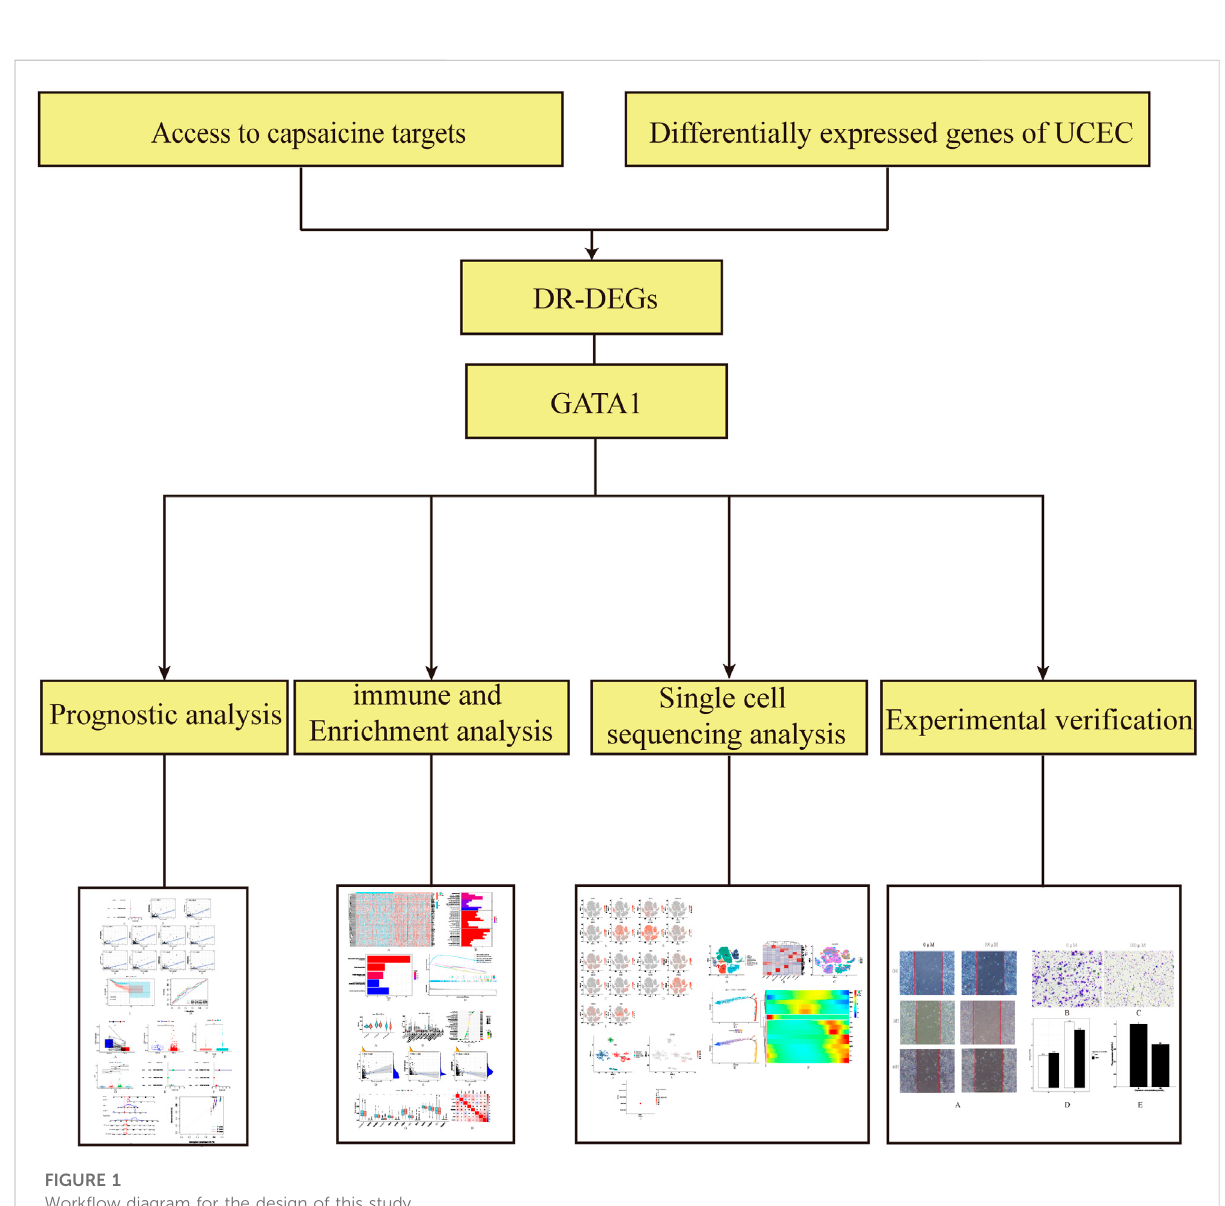
FIGURE 1 Work fl ow diagram for the design of this